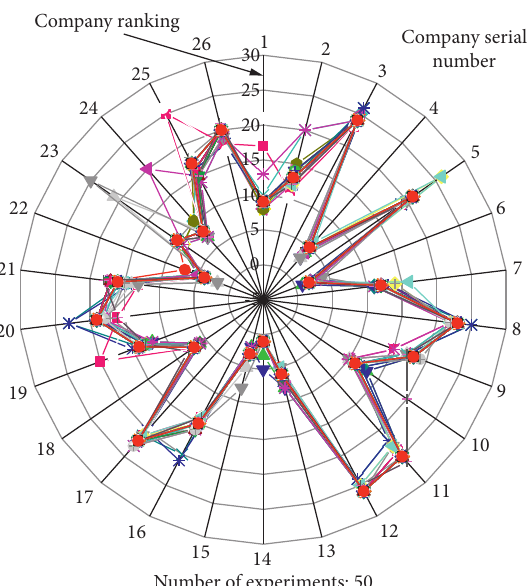
Figure 5: Weight sensitivity analysis results of the TOPSIS method.